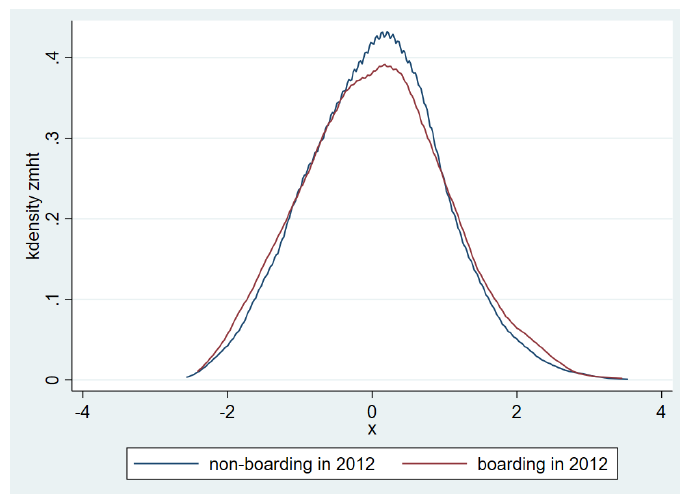
Figure 2. Distribution of students’ standardized MHT scores in samples from 2012.